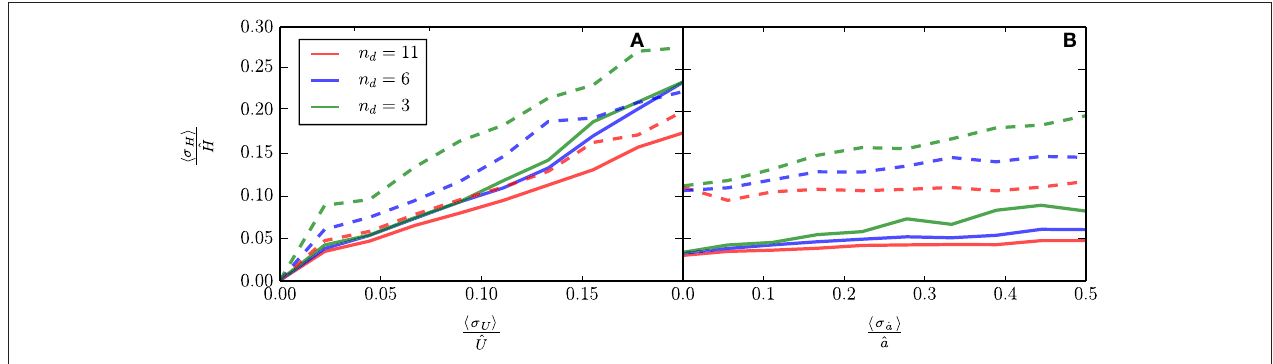
FIGURE 3 | Relationship between average thickness uncertainty and velocity uncertainty (A) and mass balance uncertainty (B). Solid lines reflect the case where the other variable is being held constant at a low level of uncertainty (e.g., mass balance held fixed while velocity is varied), while dashed lines represent the case where the other variable is held constant at a high uncertainty. These curves are computed for three different data densities.